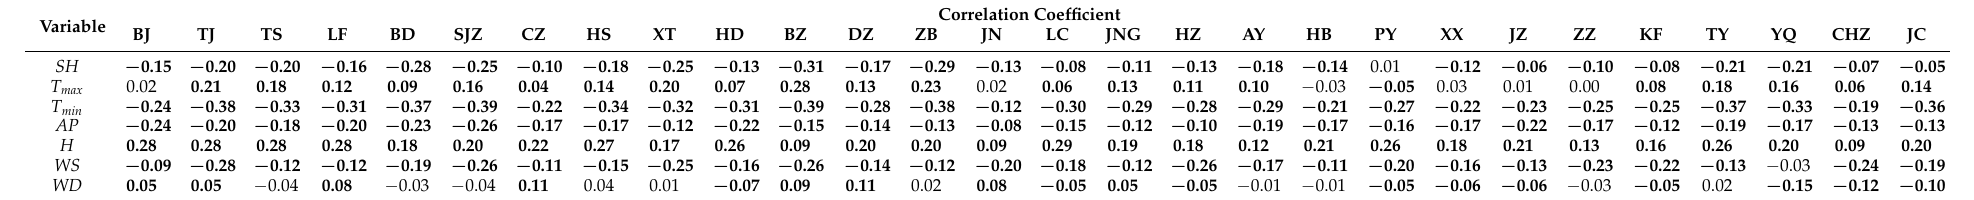
Table 1. Partial correlations of PM 2.5 concentration with meteorological variables based on daily data during 2014–2019: SH , sunshine hours; T max , daily maximum temperature; T min , daily minimum temperature; AP , average atmospheric pressure; H , average relative humidity; WS maximum wind speed; WD , wind direction; BJ, Beijing; TJ, Tianjin; SJZ, Shijiazhuang; TS, Tangshan; LF, Langfang; BD, Baoding; CZ, Cangzhou; HS, Hengshui; XT, Xingtai; HD, Handan; BZ, Binzhou; DZ, Dezhou; ZB, Zibo; JN, Jinan; LC, Liaocheng; JNG, Jining; HZ, Heze; AY, Anyang; HB, Hebi; PY, Puyang; XX, Xinxiang; JZ, Jiaozou; ZZ, Zhengzhou; KF, Kaifeng; TY, Taiyuan; YQ, Yangquan; CHZ, Changzhi; JC, Jincheng.